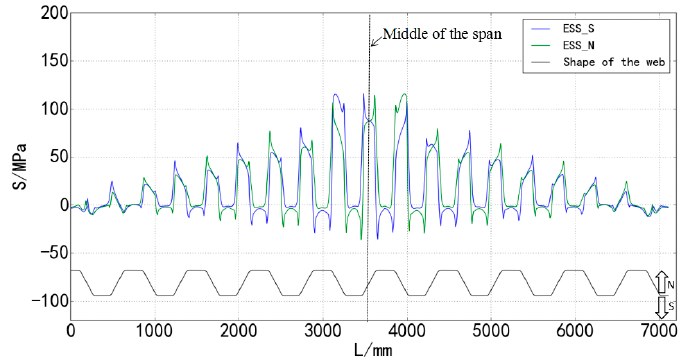
Figure 6. The global ESS distribution curve.